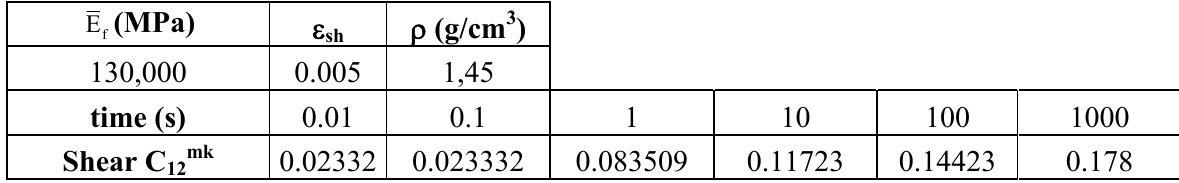
Table 1. Mechanical properties of the pre-impregnated composite fabric [62].